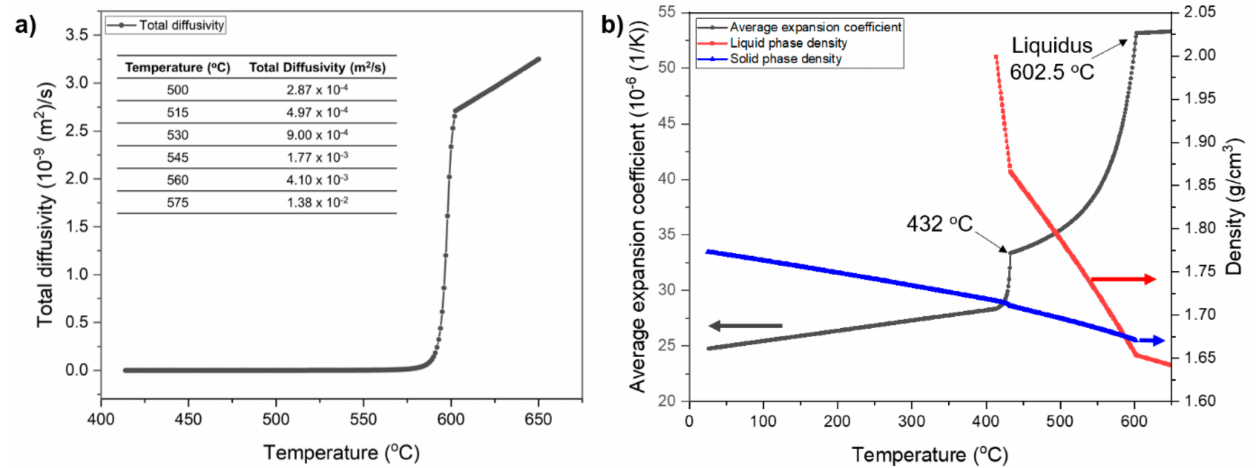
Figure 8. Temperature dependence of Mg- 8.79 wt. % Al- 0.46 wt. % Zn- 0.17 wt. % Mn- 0.05 wt. % Si calculated by thermodynamic software. ( a ) Total diffusivity coefficient and ( b ) density and average expansion